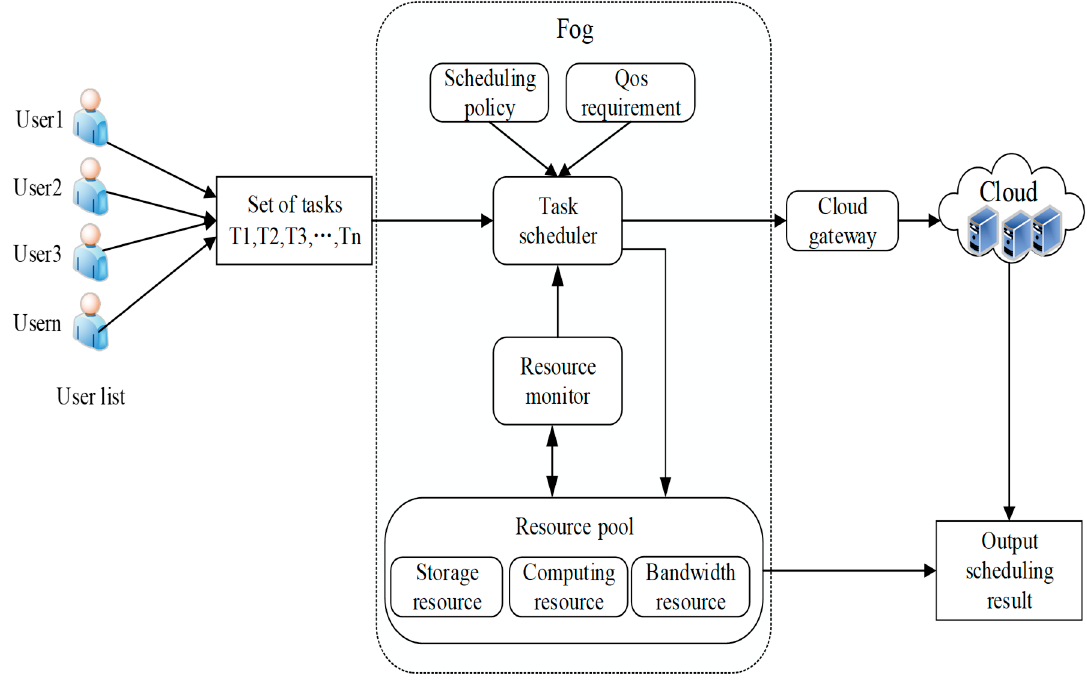
Figure 2. Fog computing resource scheduling process.